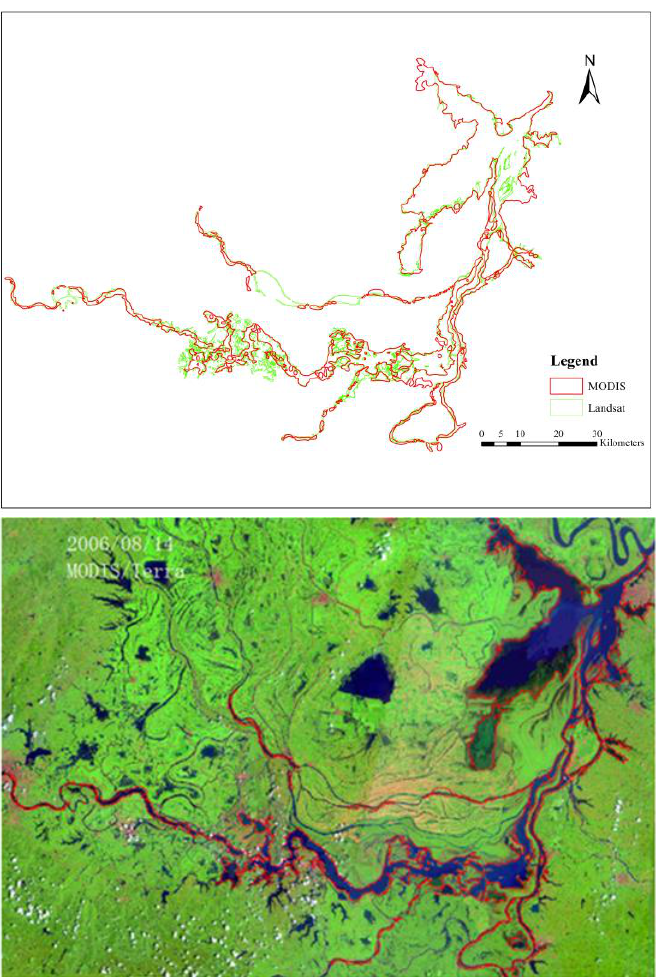
Figure 2. Comparison of water area boundary extracted by MODIS and Landsat in the same period.